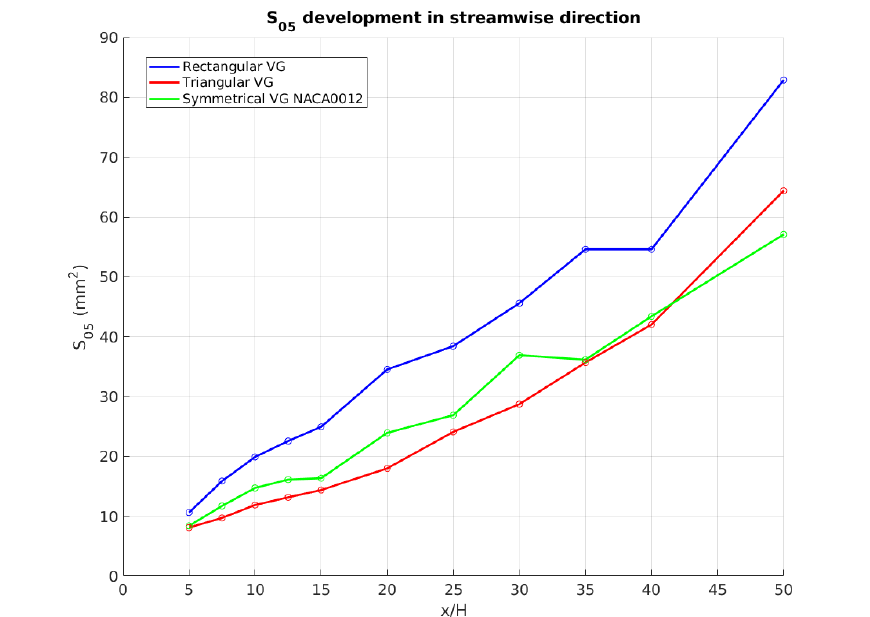
Figure 14. Evolution of the analyzed S 05 parameter for the primary vortex size computed in the streamwise direction